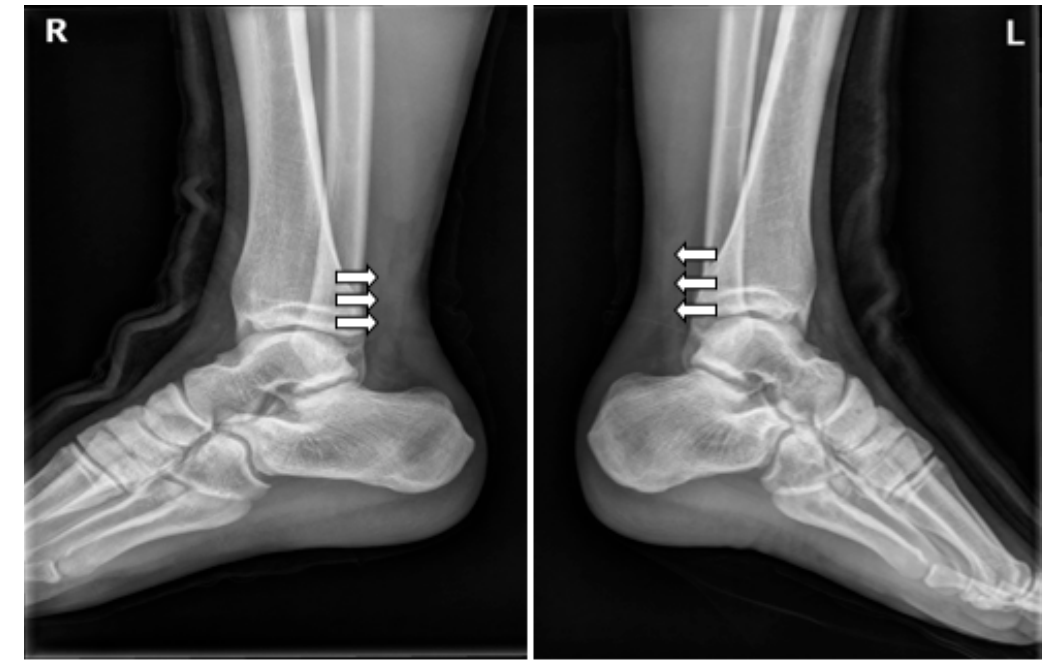
Figure 2. Lateral conventional radiographs of both ankles following bilateral Achilles tendon rupture show marked thickening of the Achilles tendons, loss of the normal sharp anterior borders (white arrows), and effacement of the pre-Achilles/Kager’s fat pad.